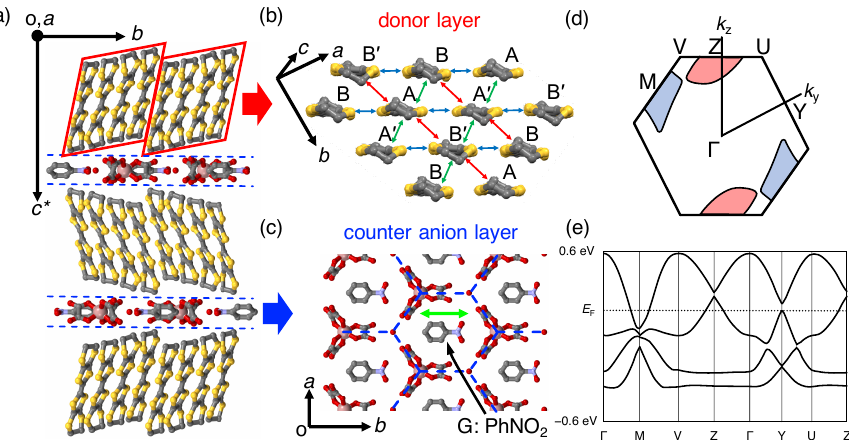
Figure 1. ( a ) Interlayer packing structure of β (cid:48)(cid:48) -(BEDT-TTF) 4 AM (C 2 O 4 ) 3 G . The red rhombi indicate tetramers of the BEDT-TTF molecules, and the blue dashed lines represent the counter anion layers. ( b ) Arrangement of the BEDT-TTF molecules in the β (cid:48)(cid:48) -type packing motif. In this 4:1 β (cid:48)(cid:48) -phase, there are the two crystallographically independent BEDT-TTF molecules, A and B. The arrows signify trans- fer integrals between them along the diagonal (red), stacking (green), and horizontal (blue) directions. ( c ) Honeycomb cavity composed of the monovalent cation A + and tris(oxalato)metallate M (C 2 O 4 ) 32 − in the counter anion layer. The guest molecule G occupies this hexagonal vacancy. ( d , e ) Fermi surface ( d ) and band structure ( e ) of β (cid:48)(cid:48) -(BEDT-TTF) 4 [(H 3 O)Ga(C 2 O 4 ) 3 ]PhNO 2 (Ga/PhNO 2 ) derived from the band calculation using the extended-H¨uckel tight-binding method